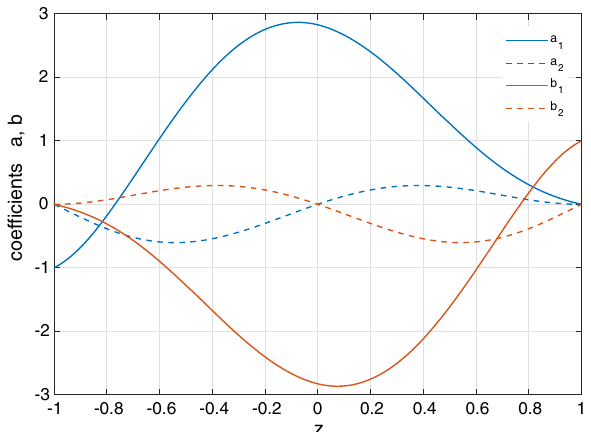
Fig. 1 Coefficients a and b as functions of